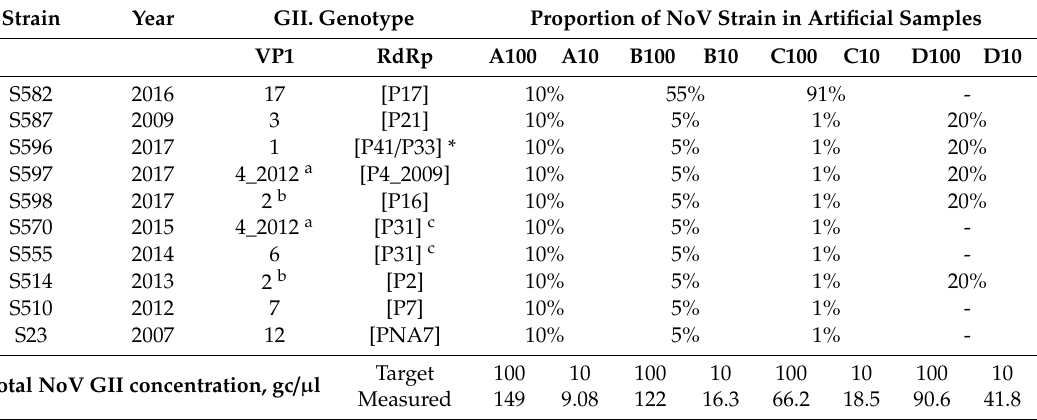
Table 2. Proportion of human noroviruses (NoV) strains in artificial samples. Strain GII.